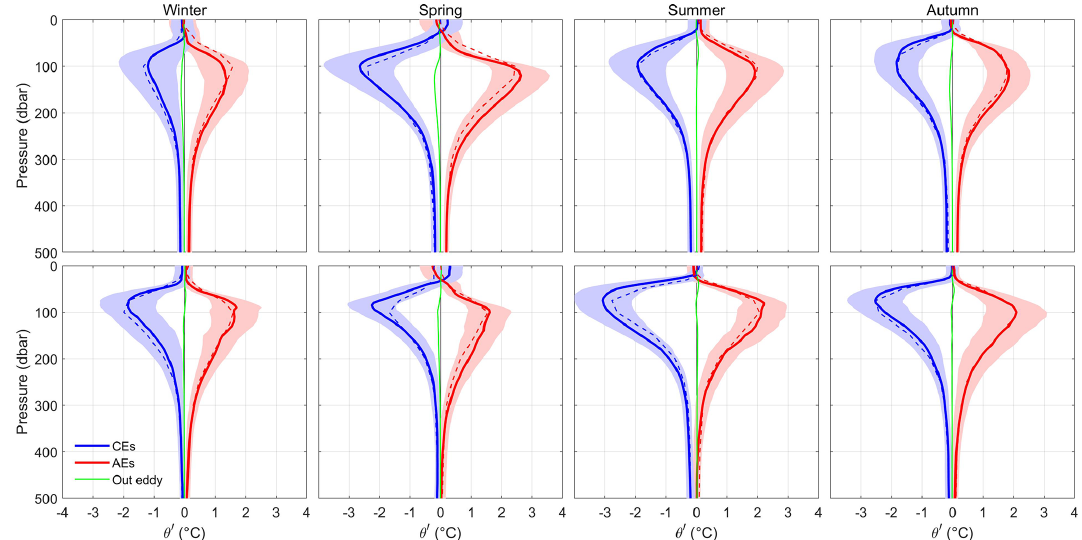
Figure 6. Mean vertical profiles of the potential temperature anomaly θ (cid:48) of composite cyclonic eddies (CEs, blue lines) and anticyclonic eddies (AEs, red lines) in different seasons for the northern (upper) and southern (lower) bay. The green lines indicate the mean anomalies that were computed from Argo profiles outside eddies relative to the Argo seasonal-mean climatologic profiles. The solid lines indicate the mean anomalies from Argo profiles, the shading indicates the range of 1 standard deviation, and the dashed lines indicate the mean anomalies from the weekly ARMOR3D temperature and salinity field